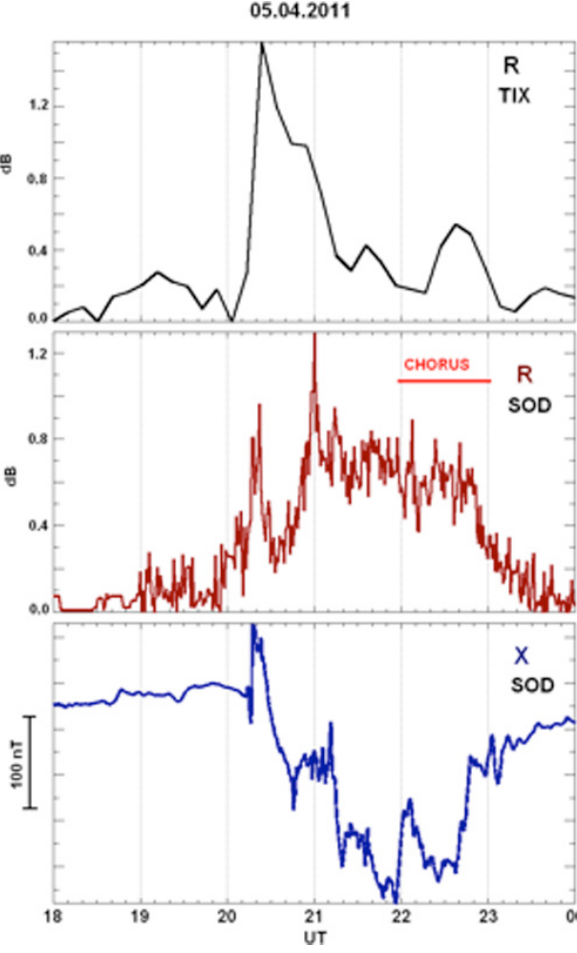
Fig. 6. Riometer data at TIX and SOD, and X-component at SOD (bottom panel) on 5 April 2011.